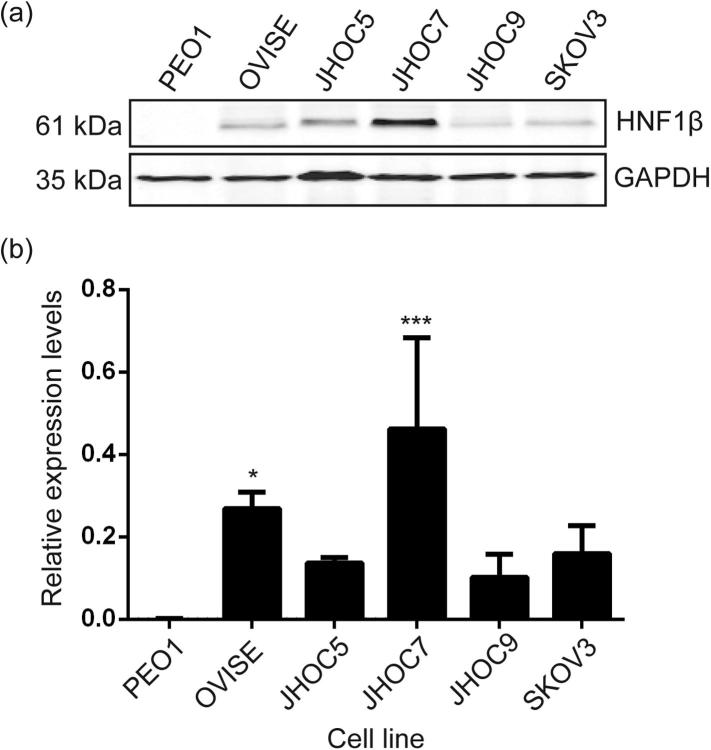
(A) HNF1β protein expression levels in CCC cell lines OVISE, JHOC5, JHOC7, JHOC9, SKOV3 and a negative control HGSOC cell line, PEO1; (B) Data is the mean (n = 3, three biological replicates) and SEM. Expression levels were normalised to the housekeeping protein GAPDH. The expression levels observed with JHOC5 (P < 0.005, ∗∗∗) and OVISE (P < 0.05, ∗) cells were significantly higher than PEO1.